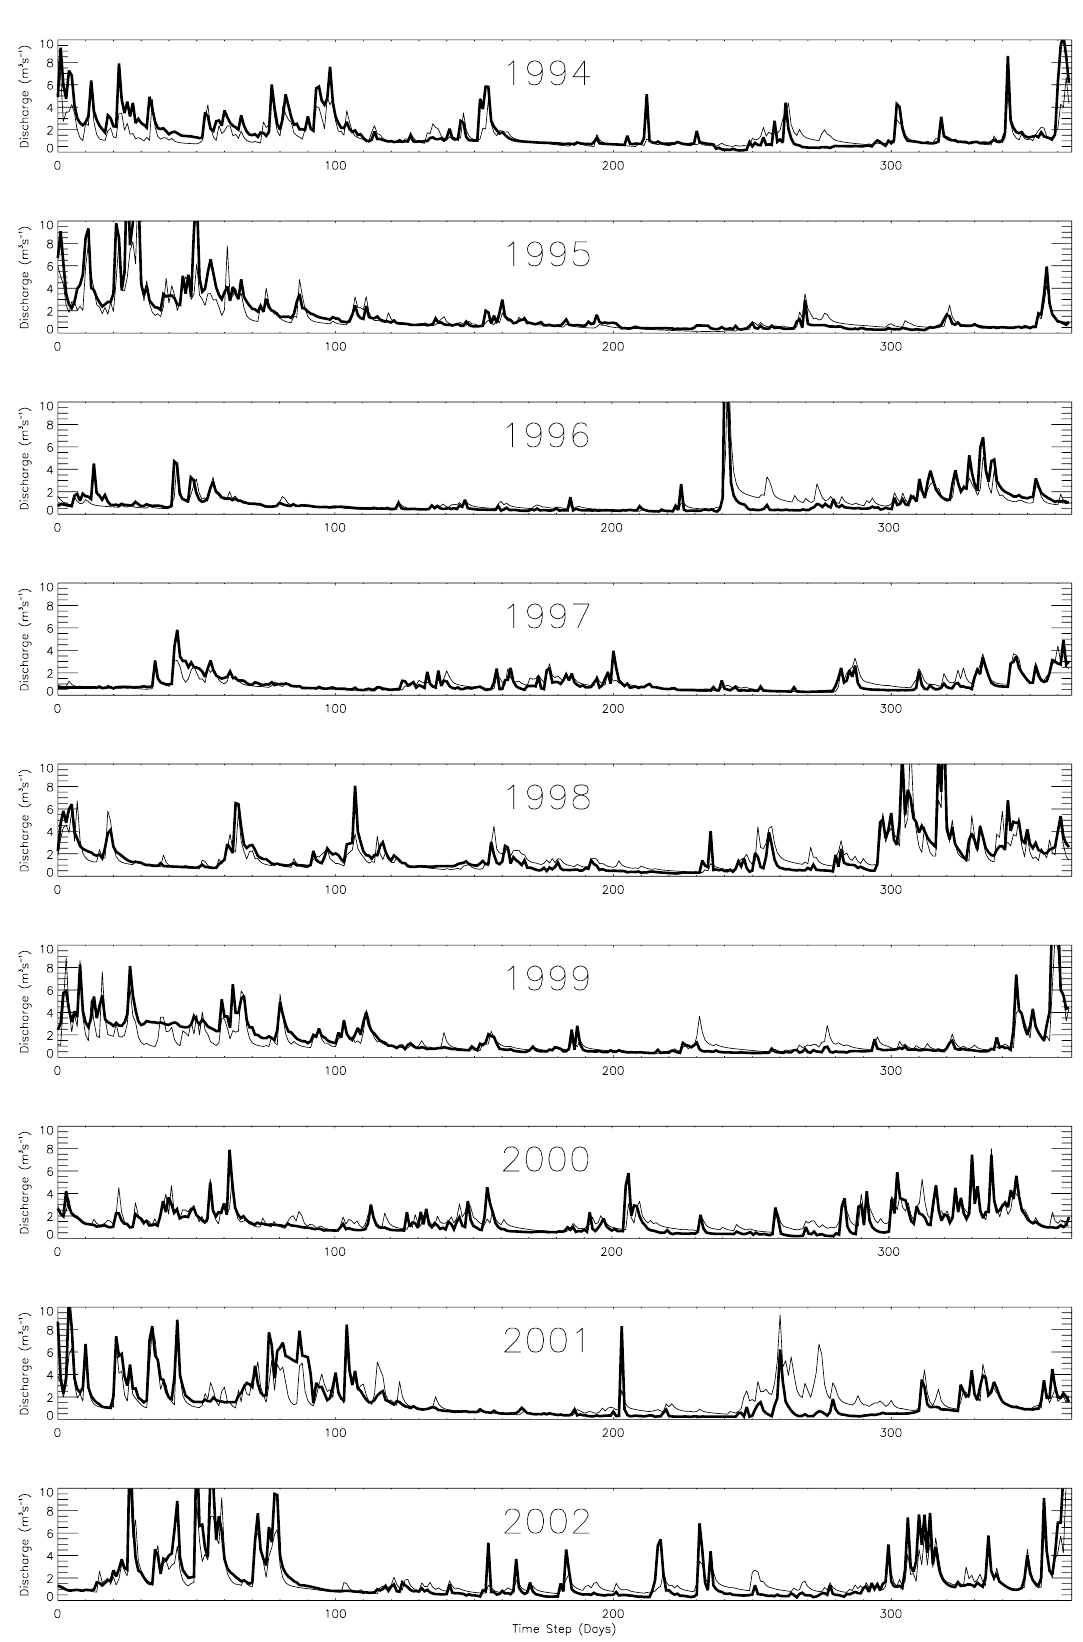
Fig. 3. Evaluation of the modeled discharge. The thick solid lines are the observed discharge, and the thin lines are the model results. www.hydrol-earth-syst-sci.net/17/3499/2013/ Hydrol. Earth Syst. Sci., 17, 3499–3521,